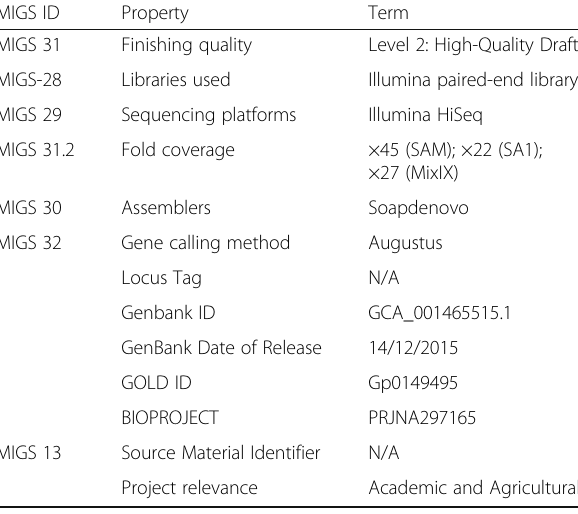
Table 2 Project